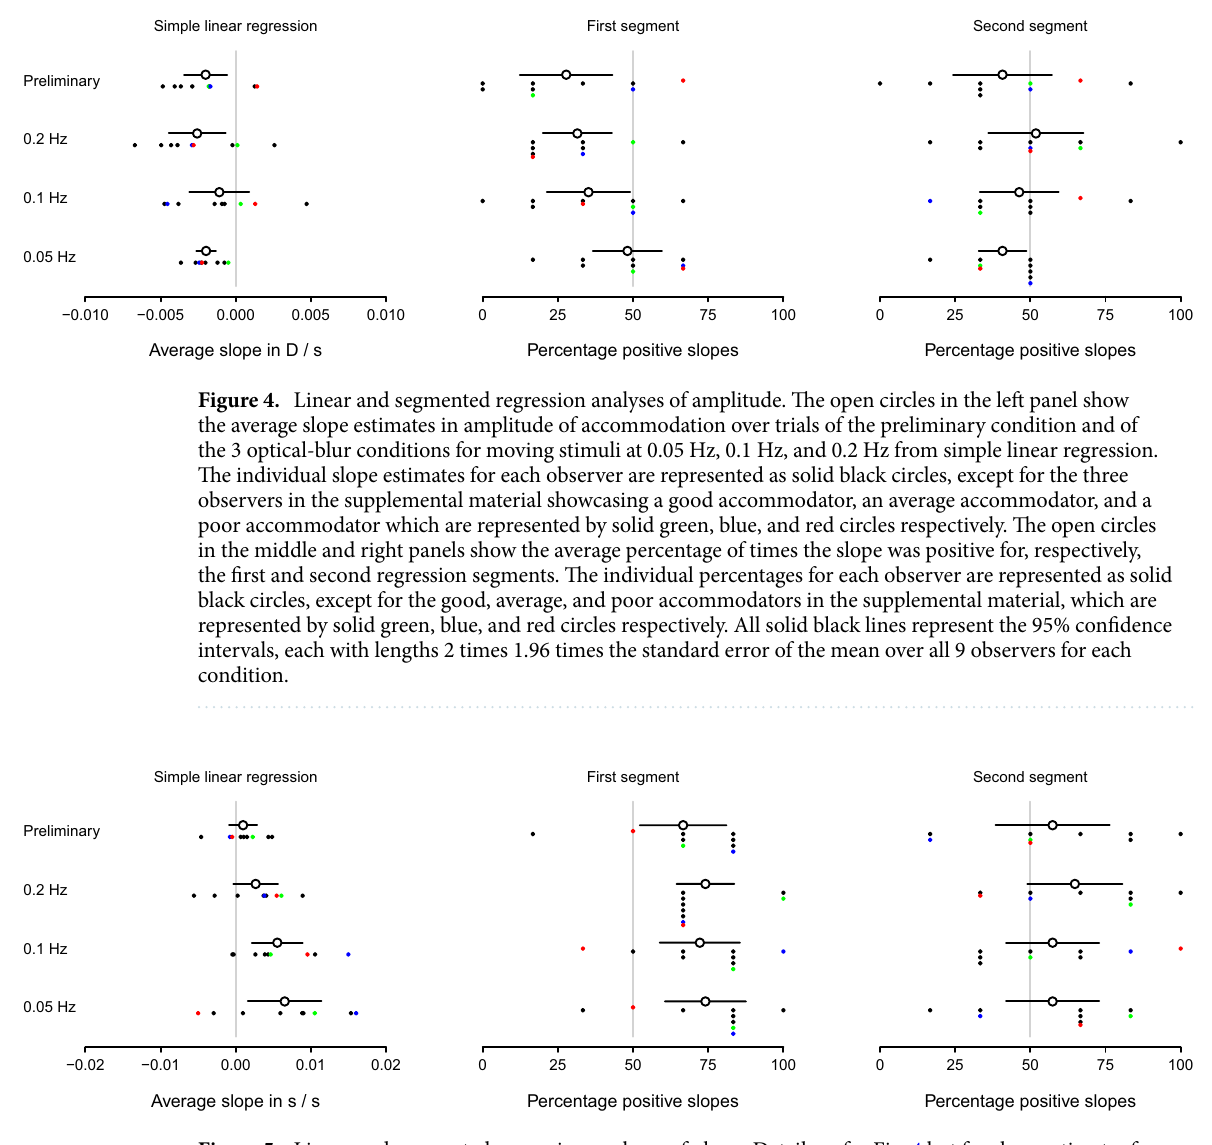
Figure 5. Linear and segmented regression analyses of phase. Details as for Fig. 4 but for slope estimates for phase, instead of